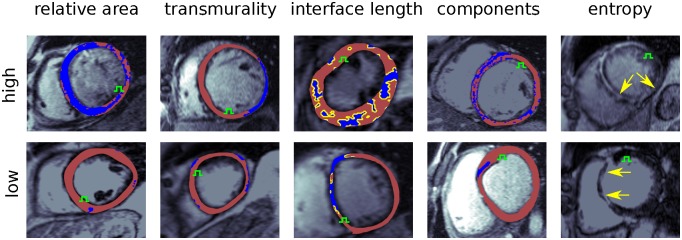
Example LGE-CMR images demonstrating high and low feature values.Areas in blue are LGE, whereas the yellow border in the interface length column shows the location of the myocardial-LGE interface. The green symbols show the stimulus sites. For the entropy images the segmentation masks are not shown to allow for visual comparison of the LGE texture.